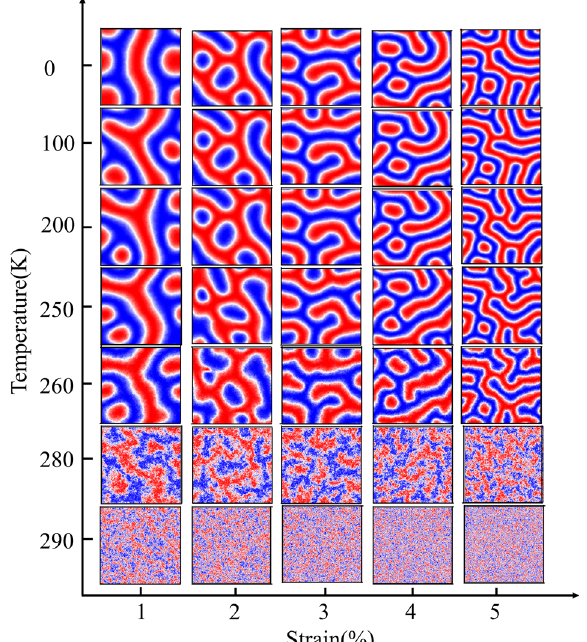
Fig. 5 Spin textures for VCuSe2 in real-space. Phase of spin con fi gurations under increased tensile strain and decreased temperature for VCuSe 2